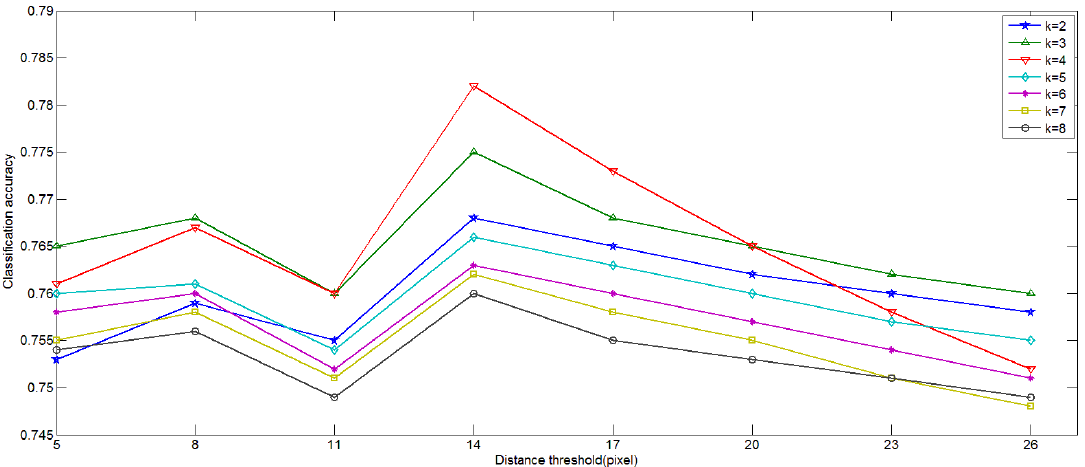
Figure 20. Classification accuracy with different distance thresholds and number of clusters over UC_MERCED dataset.